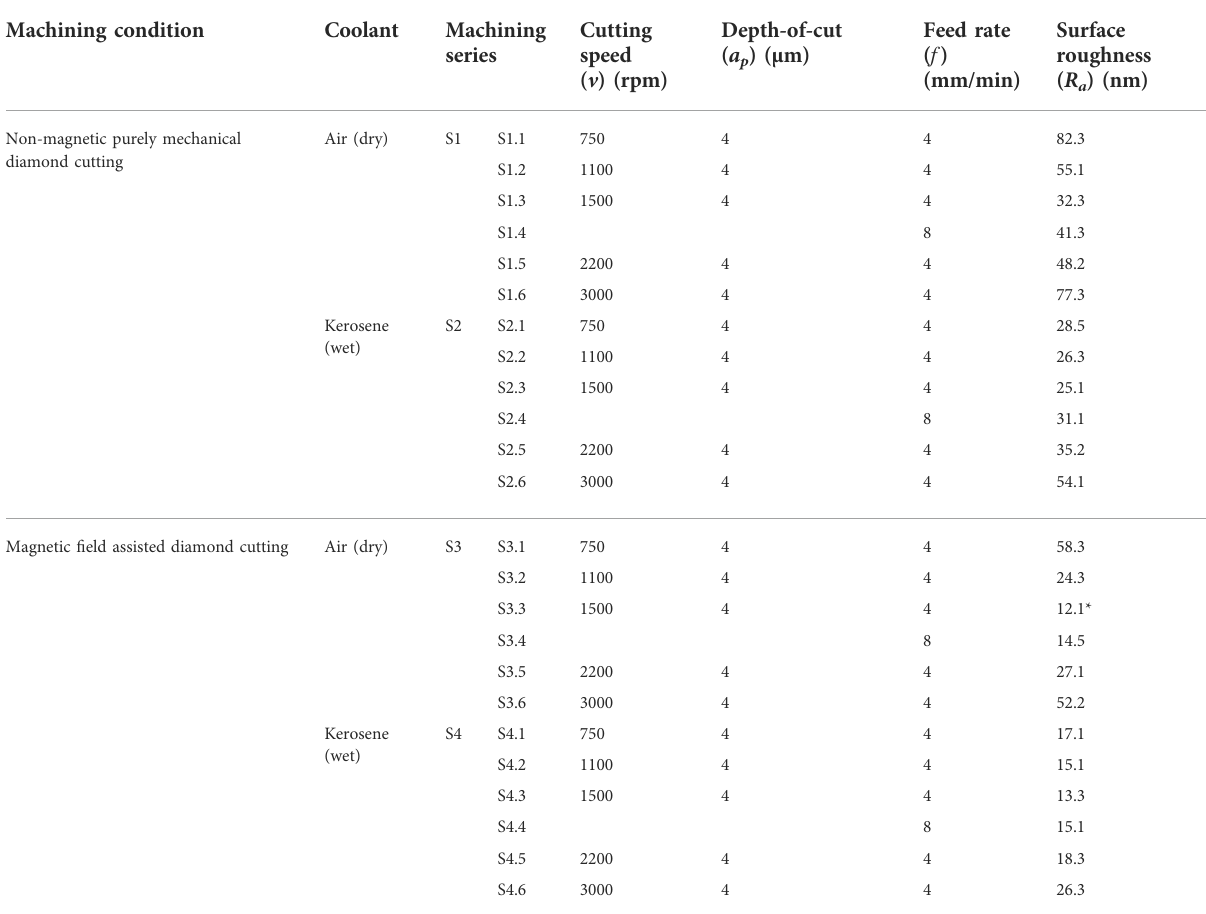
TABLE 2 Details of the machining tests and the average surface roughness of the turned samples. Machining